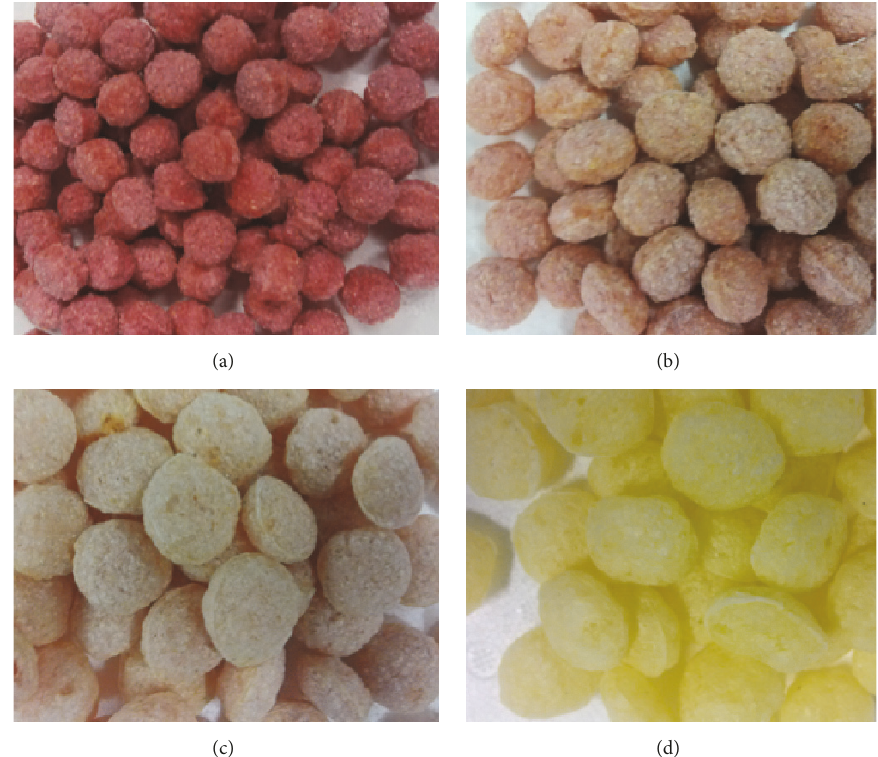
Figure 1: Extruded cereal pigmented with different content of encapsulated powder of red cactus pear; (a) 7.5%, (b) 5.0%, (c) 2.5%, and (d)